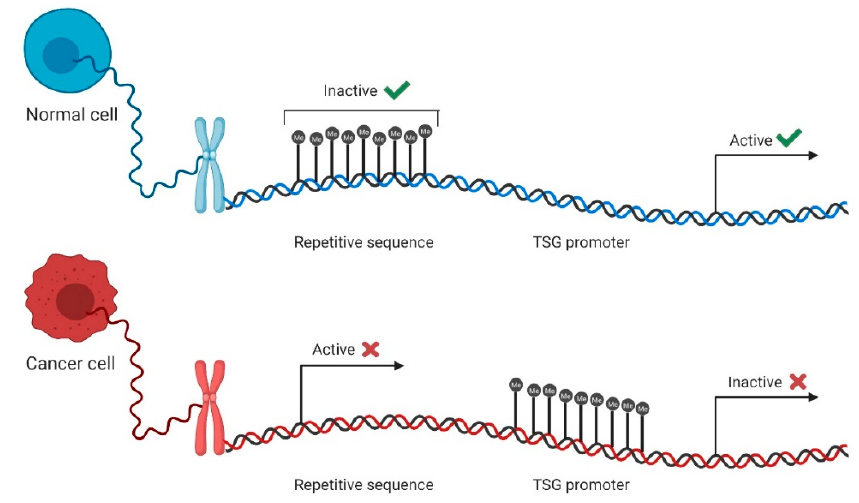
Figure 2. DNA methylation in normal and cancer cells. In normal cells, most repetitive sequences are methylated, whereas the promoters of tumor suppressor genes (TSG) stay unmethylated, remaining active and leading to gene expression (green check mark). Contrarily, in cancer cells, repetitive sequences become unmethylated and active, contributing to genomic instability, and TSG promoters become methylated, inactivating these genes and promoting cell aggressiveness and escape (red cross mark).